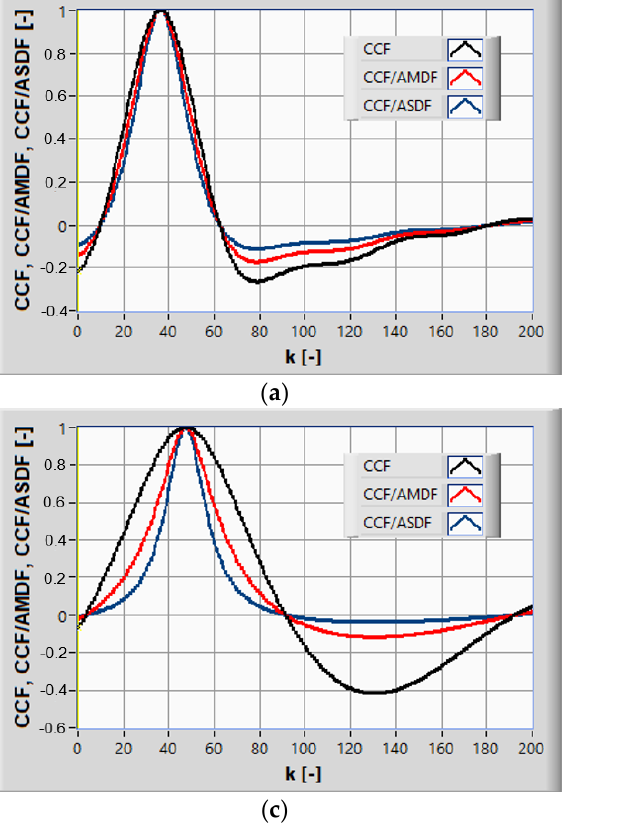
Figure 4. Normalized CCF and CCF/ASDF and CCF/AMDF functions gained in the run: ( a ) LIW1, ( b ) LIW2, ( c ) LIW4, ( d )